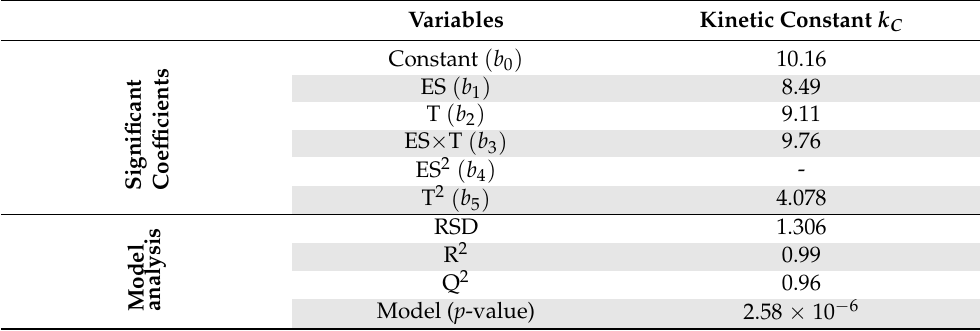
Table 3. Analysis of model results and regression coefficients of predicted model for kinetic parameter k C of cruciferin concentration.